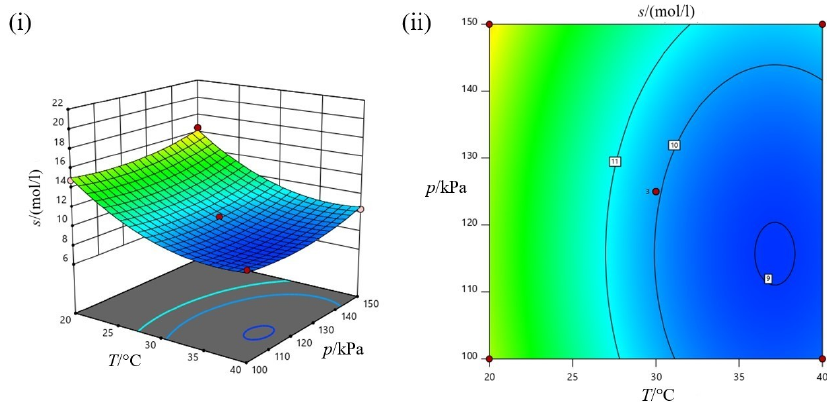
Figure 7. Effect of pressure, temperature and their interaction on CO 2 concentration in NaOH ( i ) three-dimensional surface plot; ( ii ) projected contour plot.